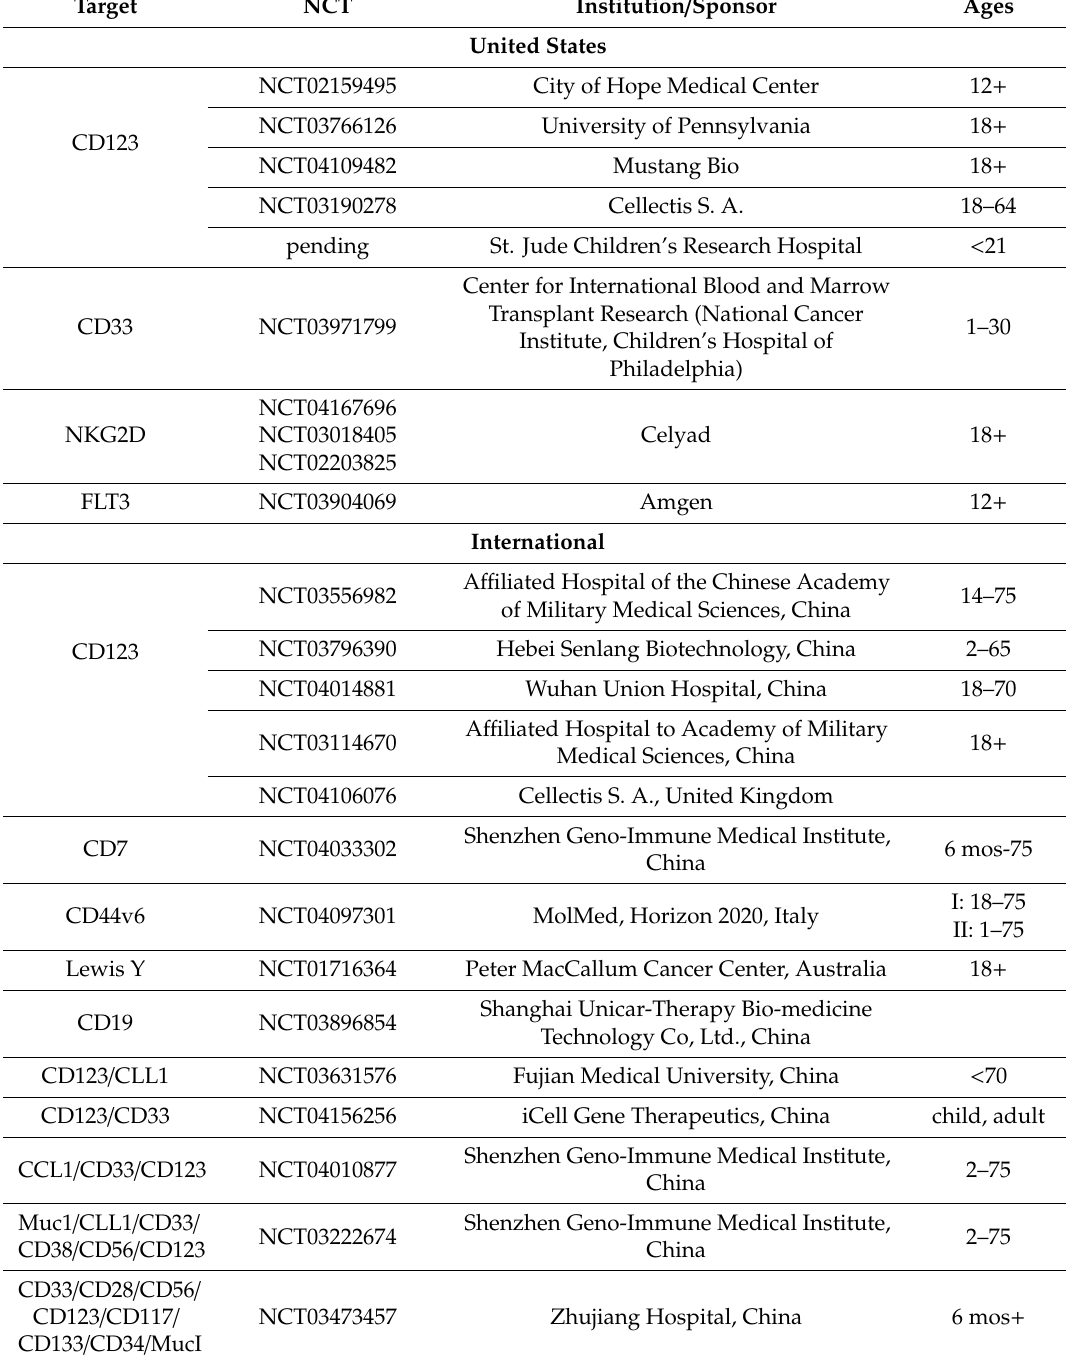
Table 2. CAR T-cell clinical trials for